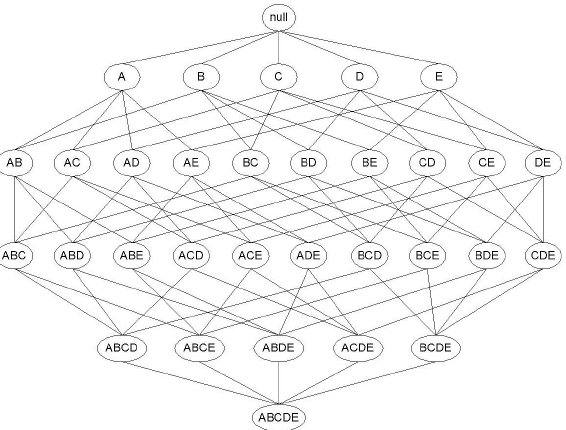
Figure 1. Combinations of five products for the purpose of generating association